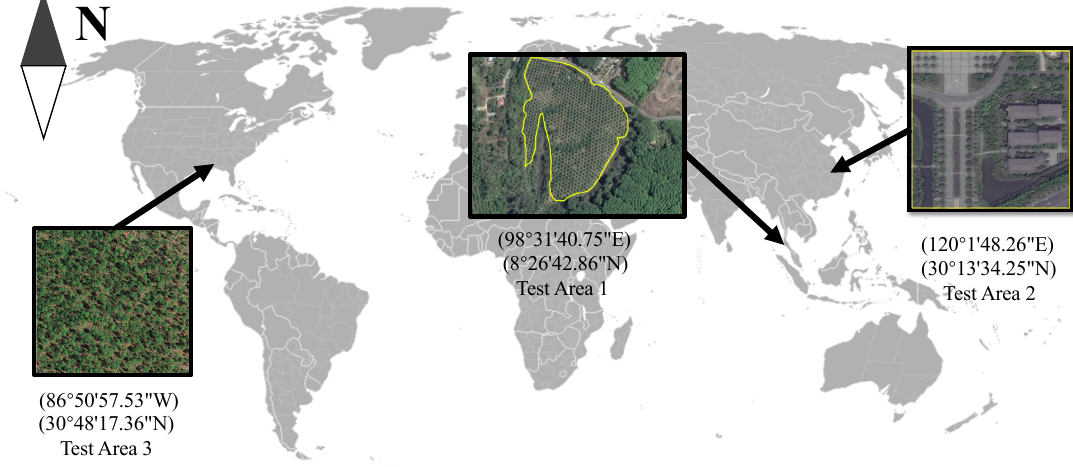
Figure 1. Schematic diagram of test